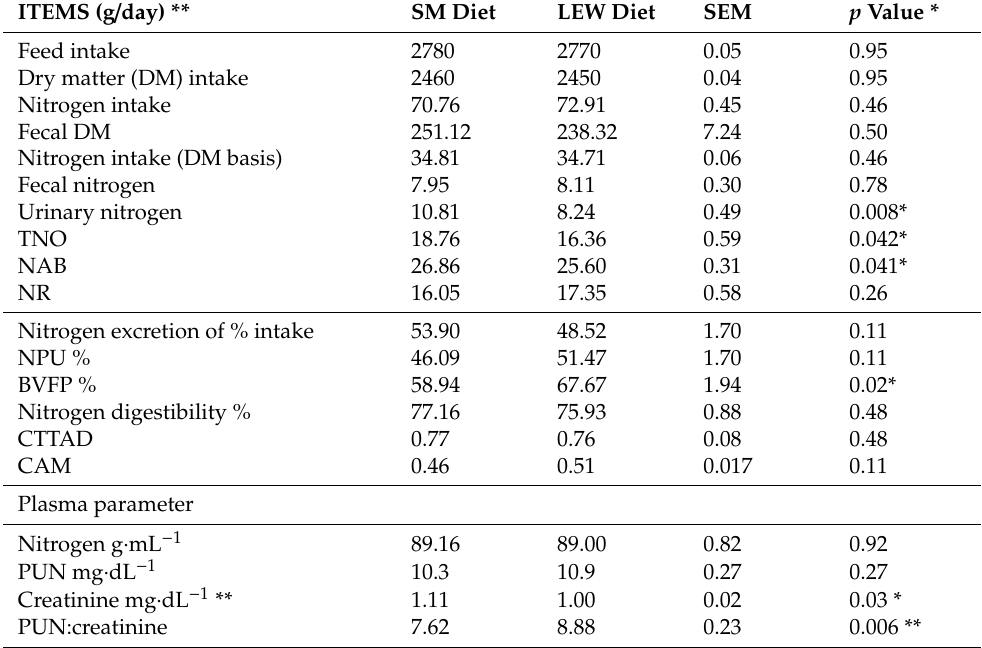
Table 2. E ff ect of dietary extruded linseed:walnut meal 50:50 ( wt / wt) mix on feed intake, nitrogen intake, nitrogen output, retained and absorbed nitrogen, digestibility, plasma urea nitrogen and creatinine concentration in grower barrows